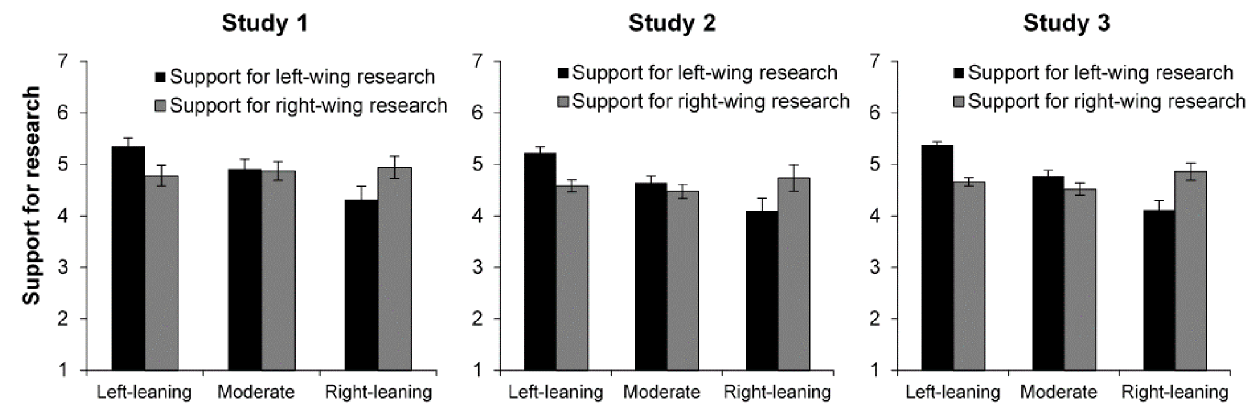
Figure 3. Support for research as a function of support for research measure ( support for left-wing research vs. support for right-wing research ) and ideology (left-leaning vs. right-leaning vs. moderate participants). Higher values represent stronger support for research. Error bars denote one standard error above and below the